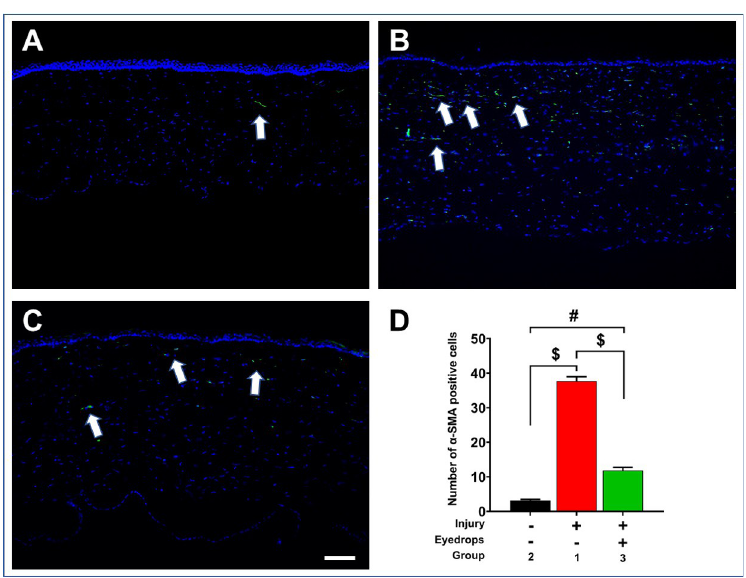
Fig 9. Representative immunofluorescence of α -SMA protein in na ï ve and wounded eyes -/+ eyedrop. A significantly increased α -SMA+ cells were found in alkali wounded rabbit corneas (B) compared to the na ï ve corneas (A). Eyedrop treatment after injury significantly decreased α -SMA+ cells in rabbit corneas (C) compared to alkali injured rabbit corneas without eyedrop treatment (B). Panel D shows quantification of SMA+ cells in corneas of 3 groups (n = 6 for each group; # = p < 0.001; $ = p < 0.0001;). Scale bar = 50 μ m.